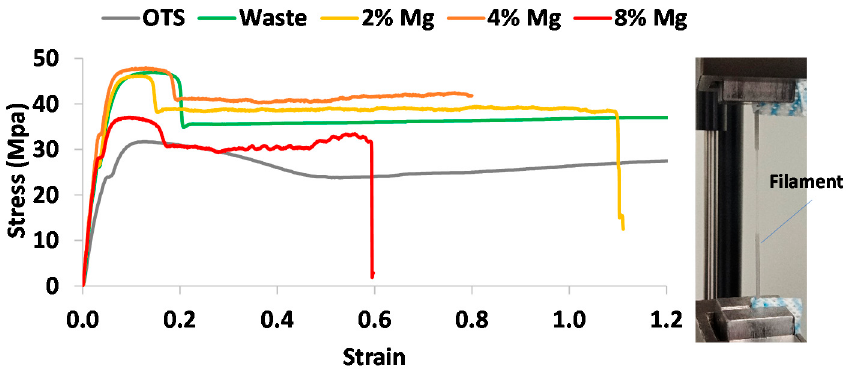
Figure 5. Tensile stress–strain profiles for different prints.